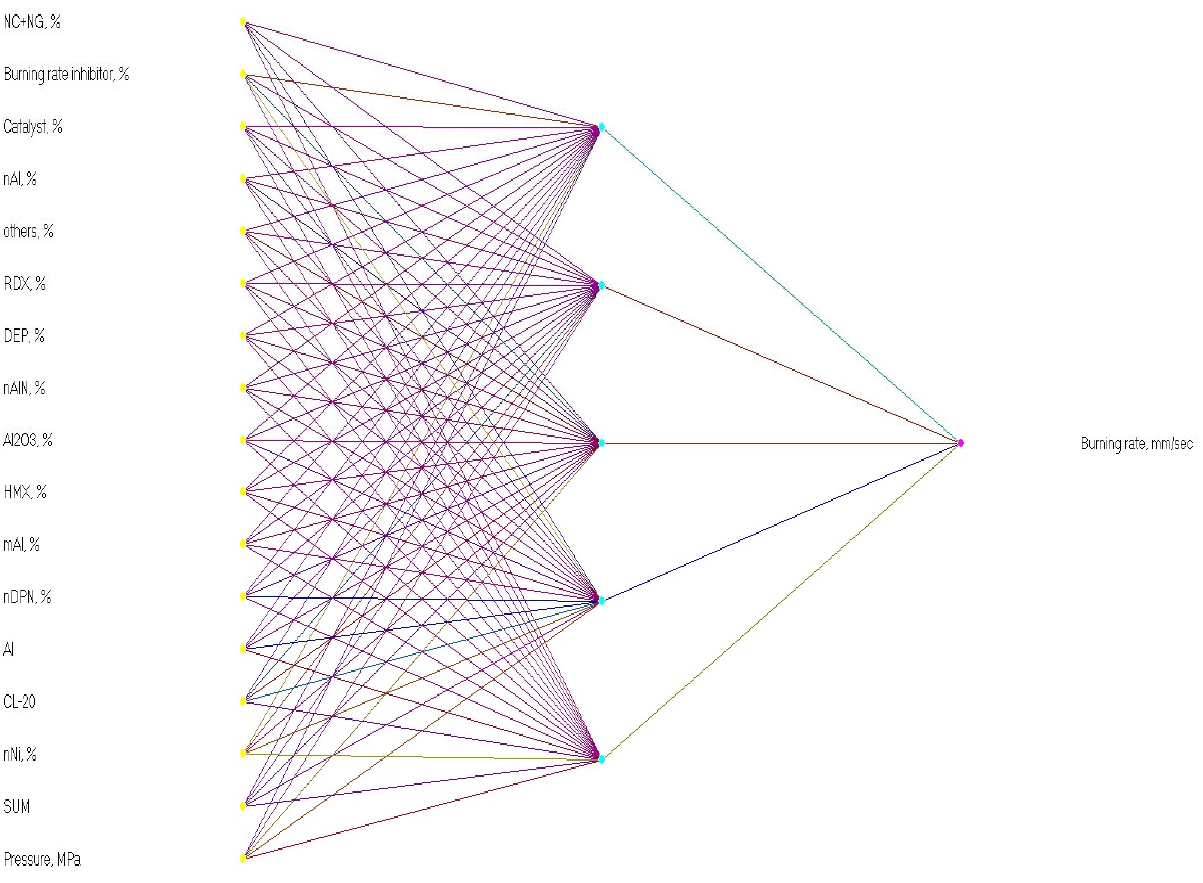
Figure 3. ANN structure for solving the direct task.